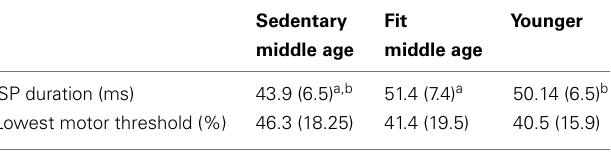
Table 6 |Transcranial magnetic stimulation